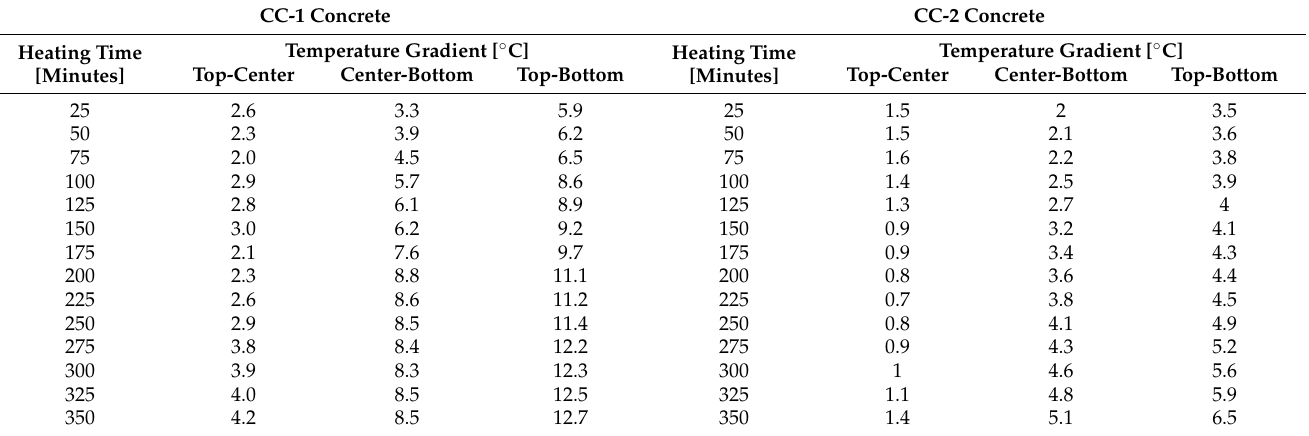
Table 7. Gradient of the average temperature of the CC-1 and CC-2 concrete depending on the heating time and